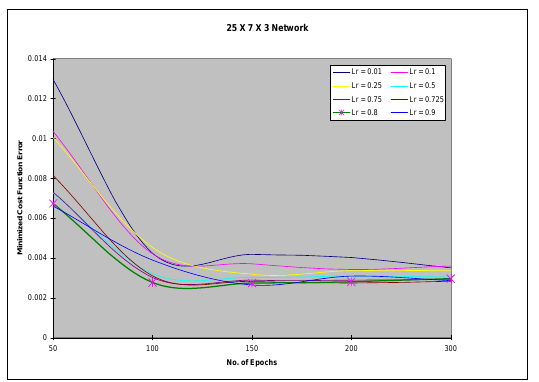
Figure 9: Network structure 25 X 7 X 3 with learning curves for varying learning rates and fixed momentum constant.